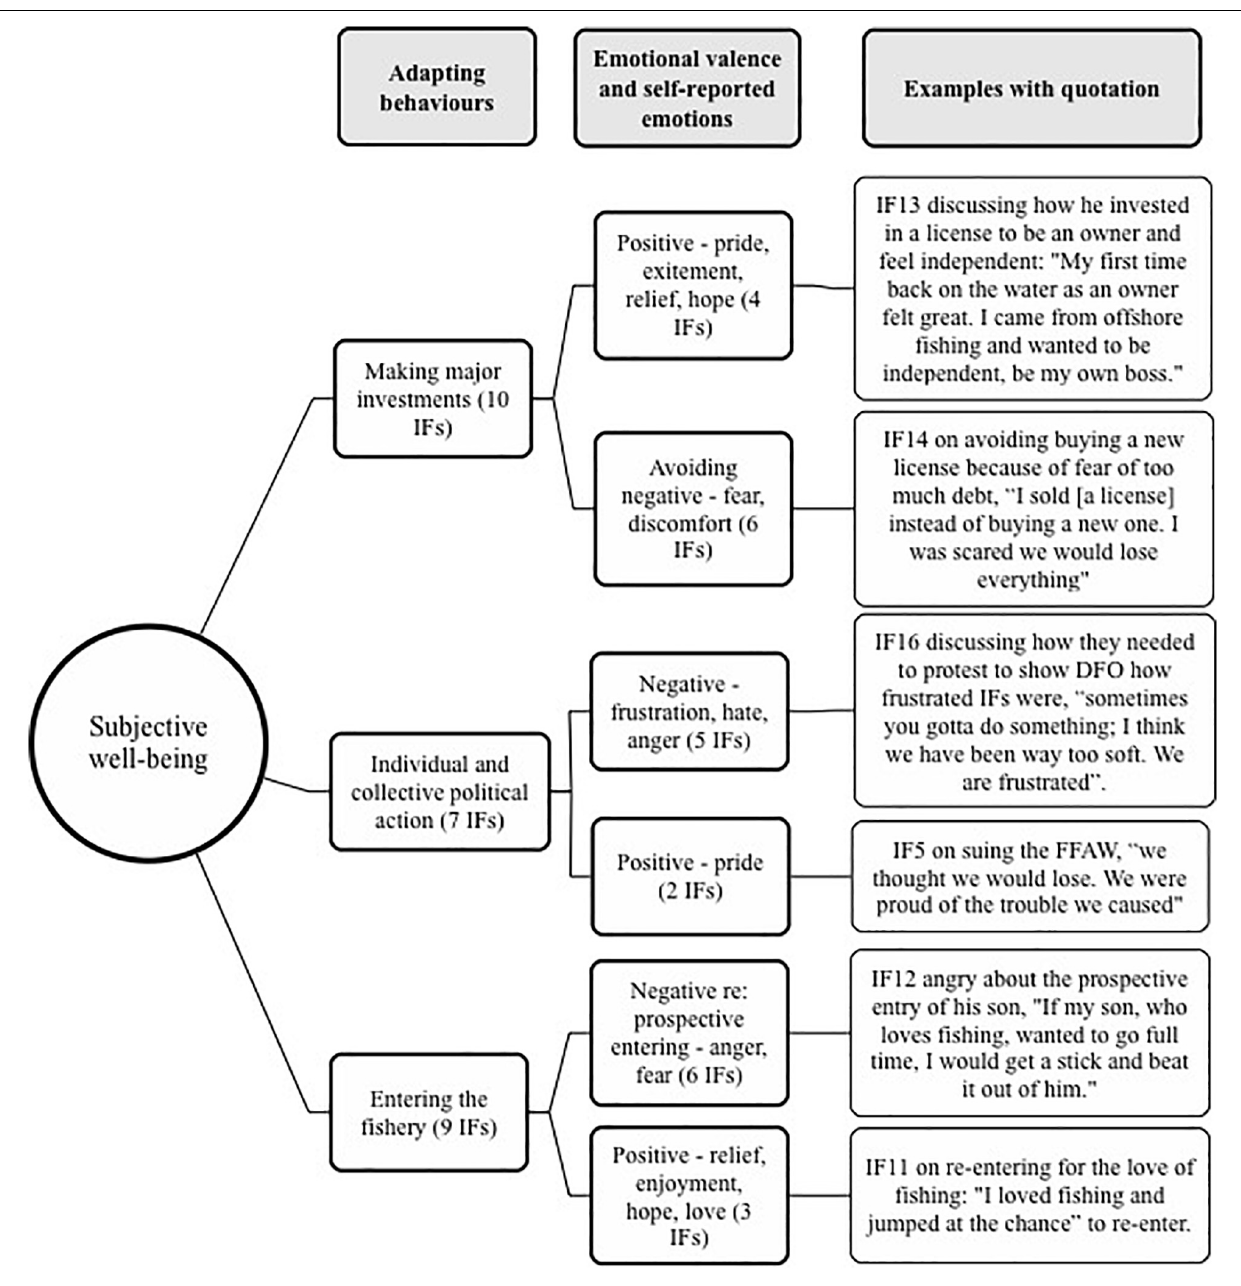
role when IFs indicated that emotions shaped their